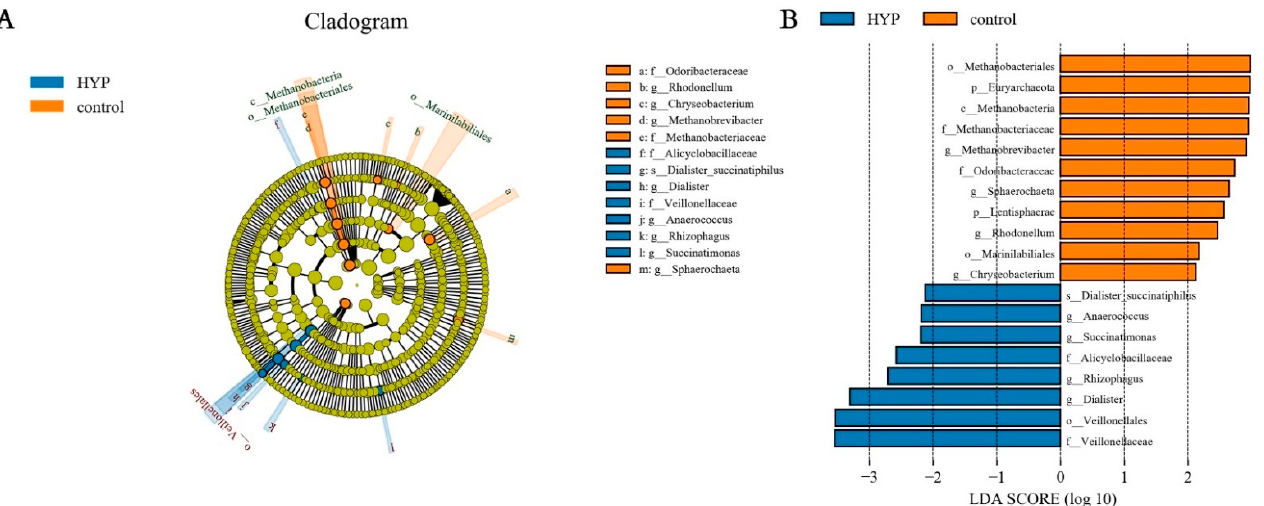
Figure 2. Effects of yeast product on the microbial composition of the rumen (LEfSe analysis). ( A ) Linear discrimination analysis (LDA) effect size (LEfSe) analysis among three groups in the SA system. ( B ) Histogram of the LDA scores computed for microorganisms differentially abundant among three groups of SA microorganisms. LDA scores (log10) > 2.0 are listed.